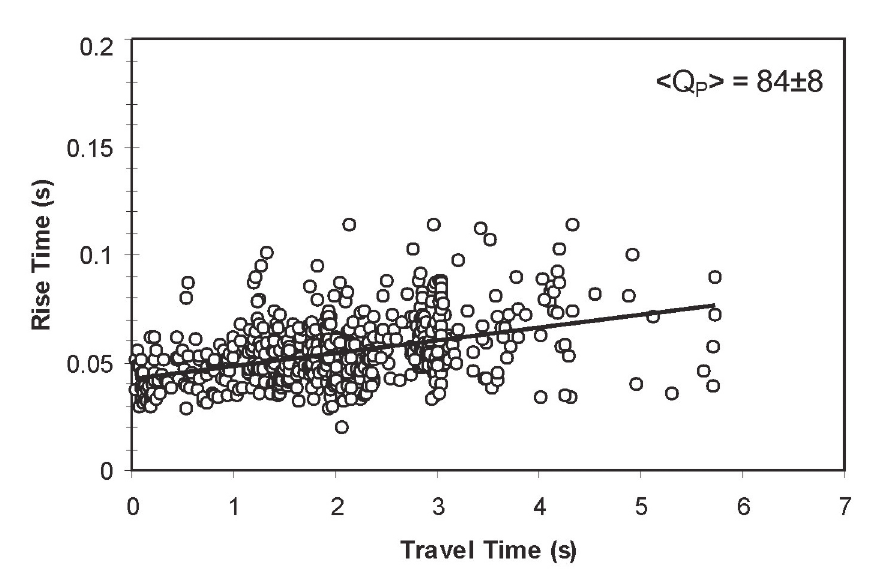
Fig. 5. Rise time plotted as a function of travel time. The best fit interpolating straight line is also shown.